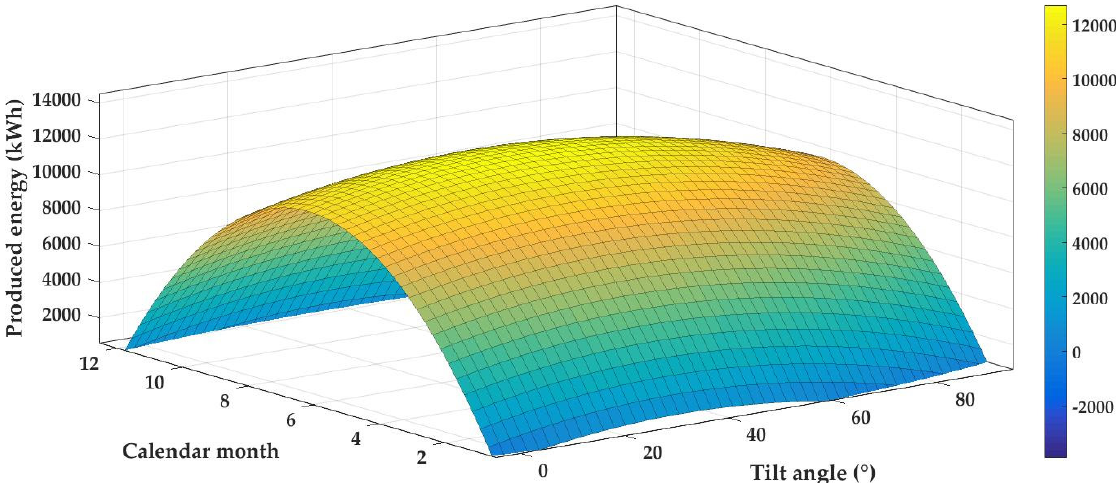
Figure 9. Three-dimensional dependence before polynomial approximation—the influence of tilt angle on the electric en- ergy production of the PV system.